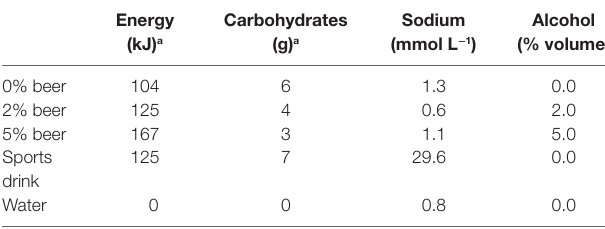
TaBle 1 | nutritional values of the